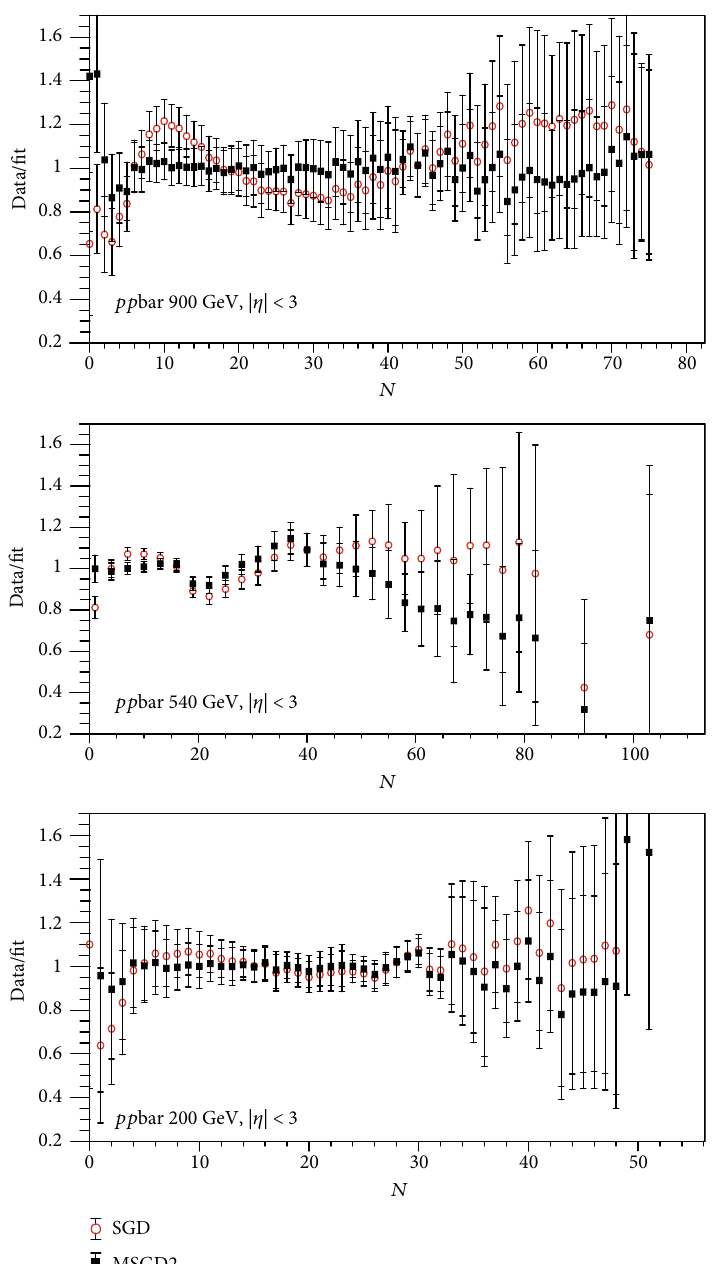
ð N Þ / P ð N Þ for the p (cid:1) p data shown in Figure 2 (red circles) and of the corrected ratio R = P data SGD